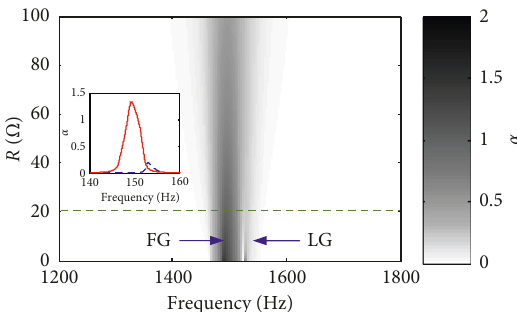
Figure 5: Variation of band gaps with shunting inductance.